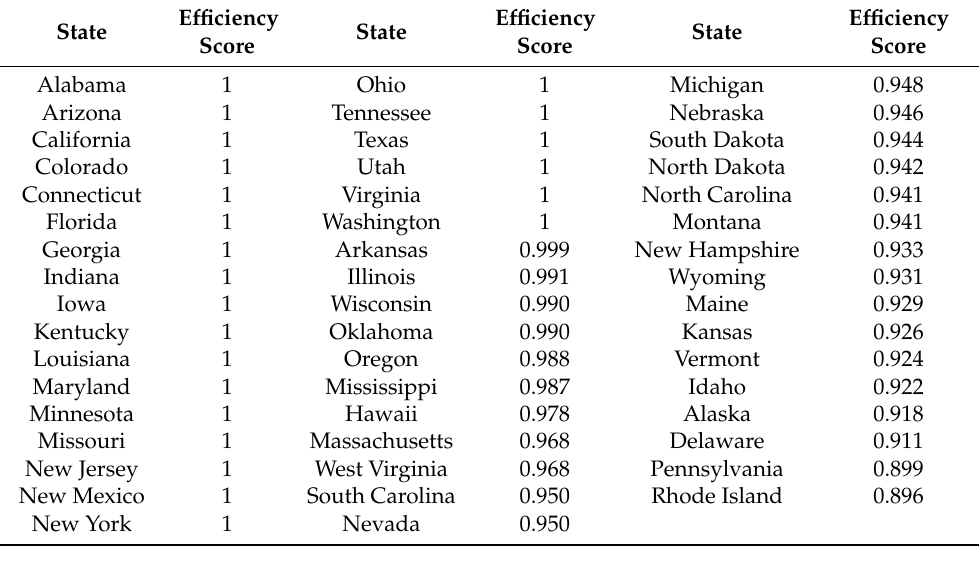
Table 6. Summary of state efficiency scores.